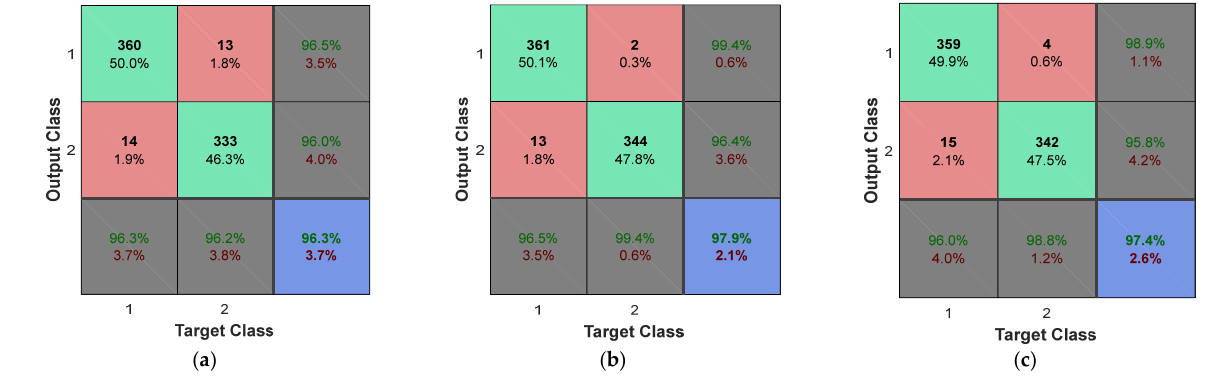
Figure 10. The confusion matrices of ( a ) KNN, ( b ) Naive Bayes, and ( c ) SVM as the results of brain tumor diagnosis in BRATS2014 database.